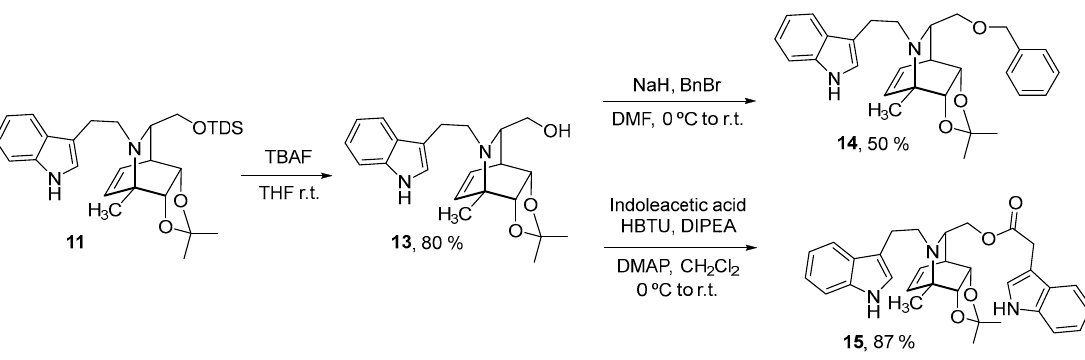
Figure 4. Synthesis of compounds 14 and 15 using analog 11 as starting material.